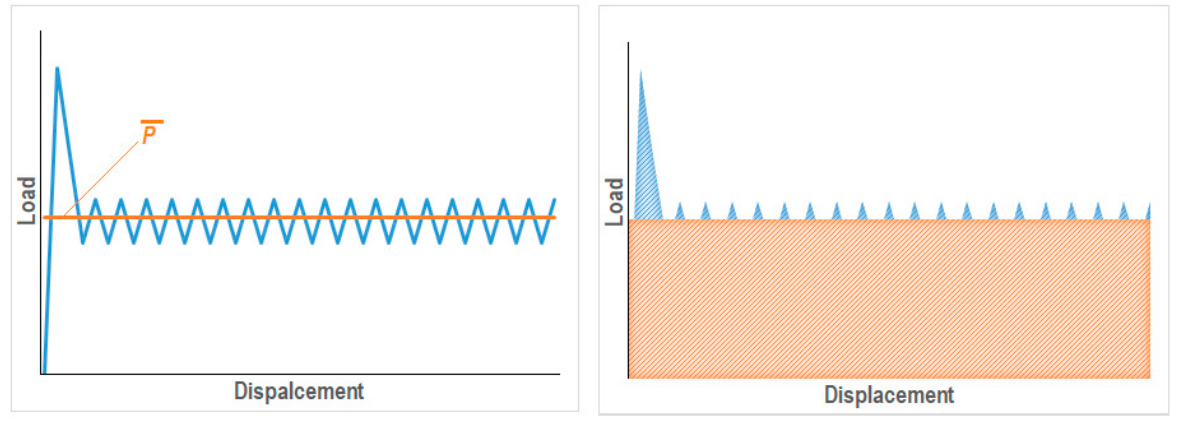
Figure 3. Typical load–displacement curve.